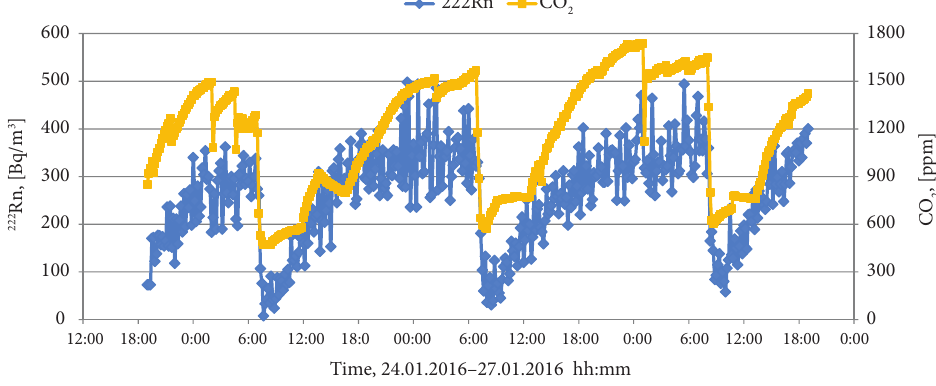
Figure 3. Indoor radon and carbon-dioxide concentration in 2016 winter at Gö6 house